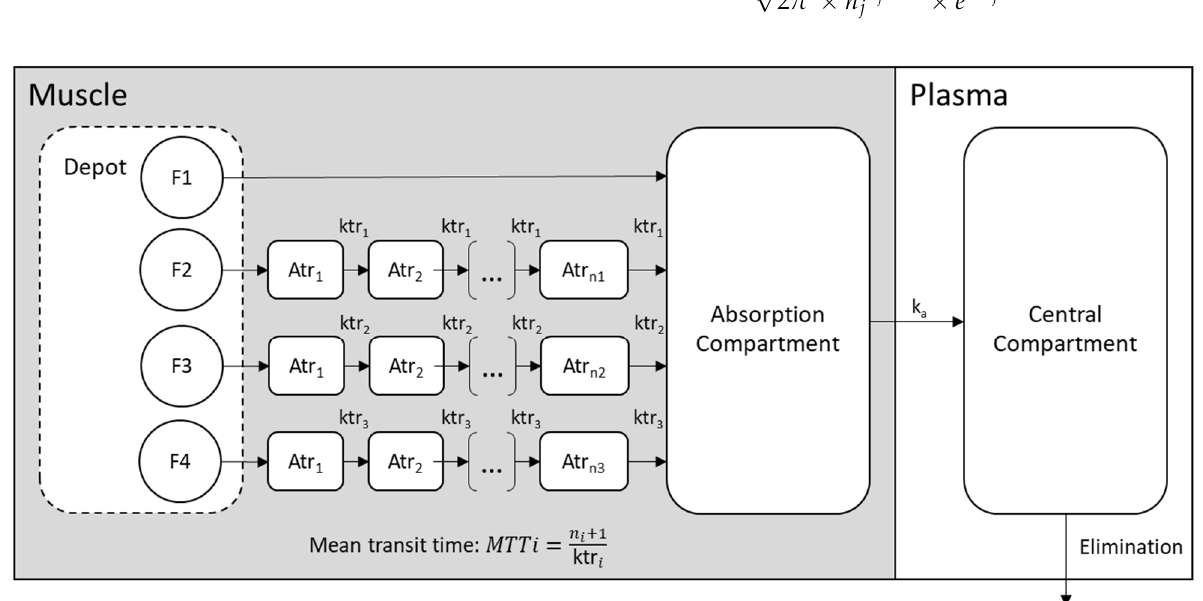
Figure 1. Graphical representation of the pharmacokinetic model which describes octreotide LAR pharmacokinetics. The drug is released from the depot to the muscle through four empirical processes with different kinetic characteristics and is then absorbed to the systematic circulation.